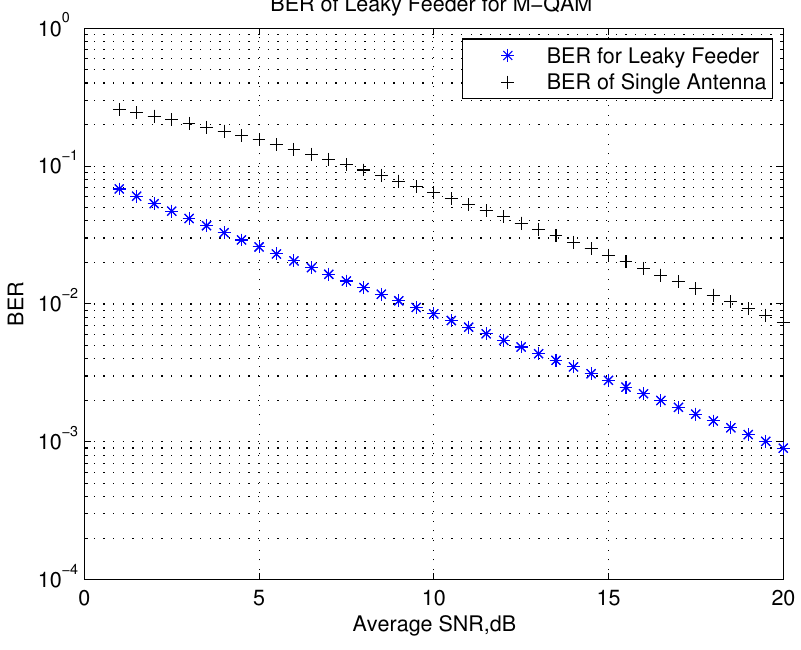
Figure 6. BER of LF vs. single antenna.